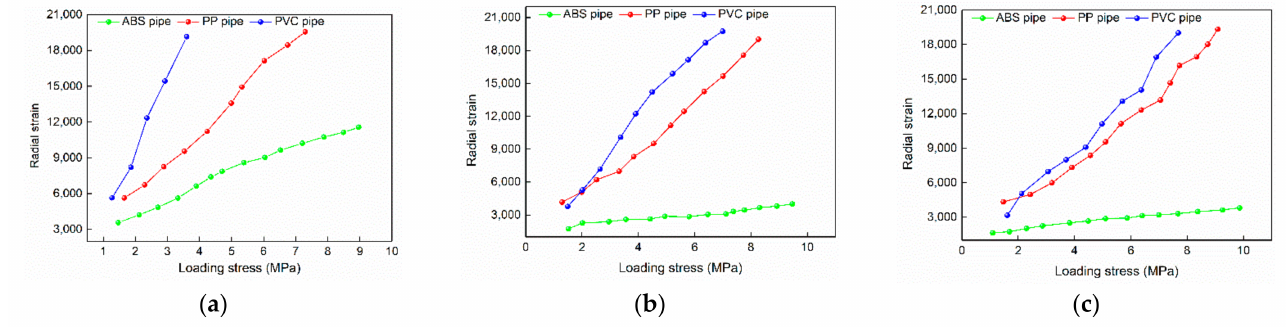
Figure 7. Loading stress–strain curves of various types of screen pipes with different sieve opening spacings: ( a ) 30 mm; ( b ) 50 mm; ( c ) 70 mm.